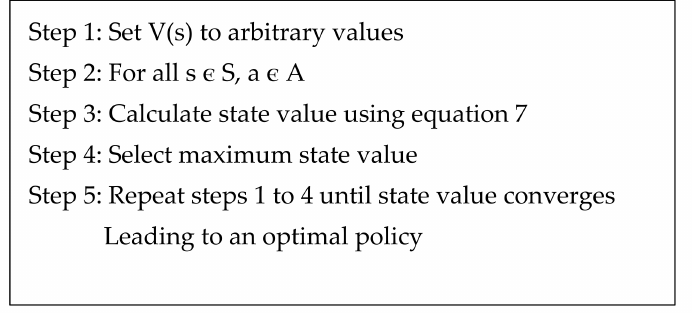
Figure 2. VIA pseudo-code.